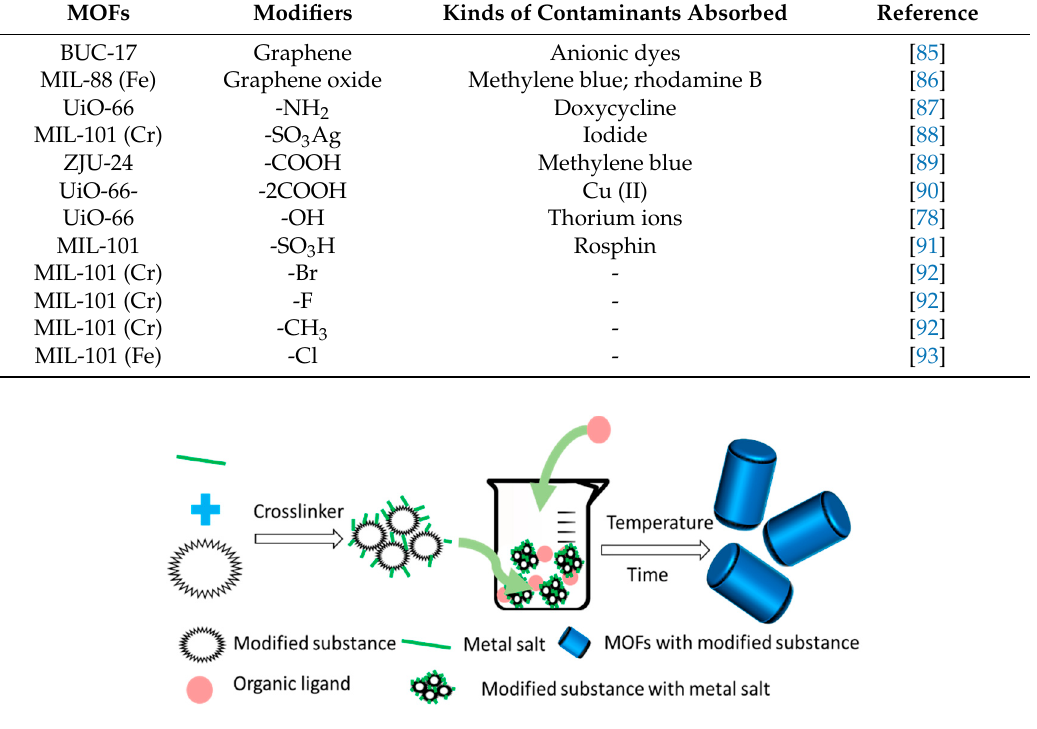
Figure 4. The route employed for the growth of MOFs with pre-synthetic modification.